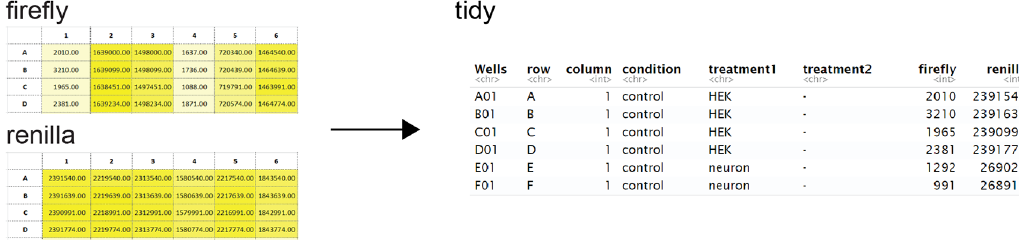
Figure 3. GloMax data conversion to tidy format. PlotXpress allows uploading of GloMax spreadsheet input. An additional experimental design file in tidy format should be provided to connect the reads with the conditions. After supplying the design file, the GloMax data is converted to a table in tidy format, where each row contains a single observation and the experimental conditions. The table can be downloaded and used as input for